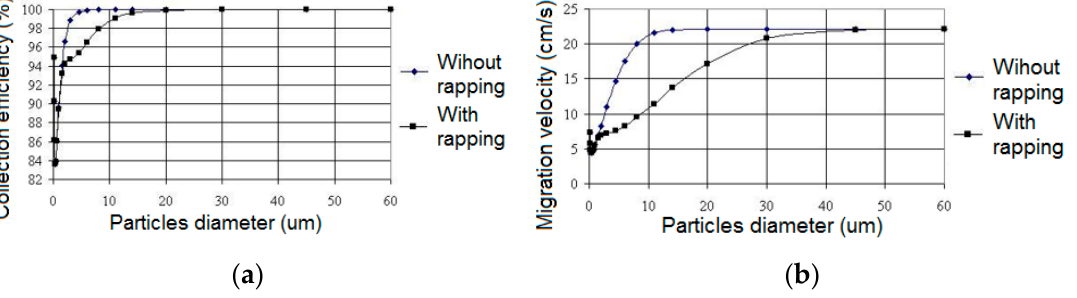
Figure 12. ( a ) The collection efficiency depends on the diameter of the dust particles. ( b ) The migration velocity depends on the diameter of the dust particles, without and with rapping, with the thickness of the dust layer: 5 mm in Section 1, 3 mm in Section 2, and 1 mm in Section 3, with an average diameter of 16 µ m.